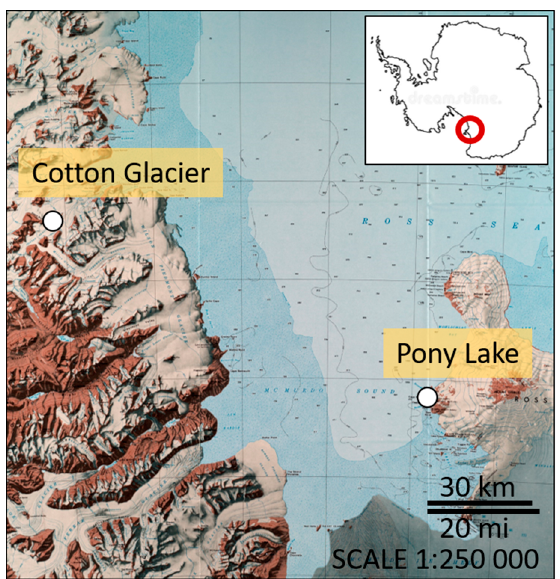
Figure 1. Map showing the location of the three sampling sites on Ross Island (Pony Lake) and the Transantarctic Mountain range (Cotton Glacier). (Credit: U.S. Geological Survey (USGS) Topographic Reconnaissance Series, 1986).